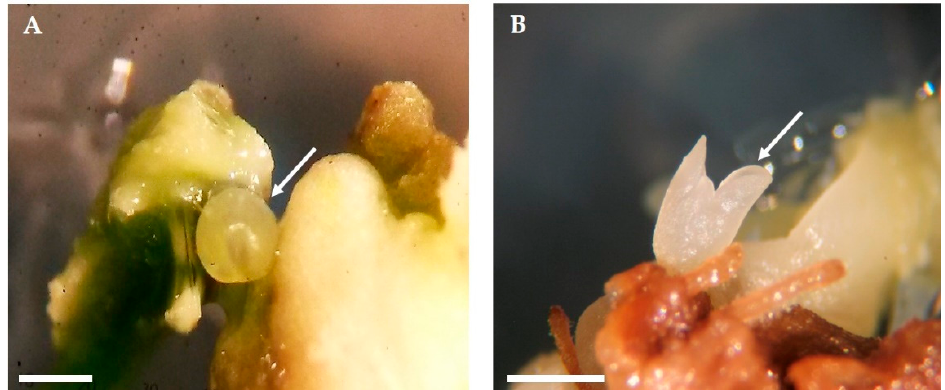
Figure 4. Somatic embryos on the two light regimes 30 days after inoculation in OMc medium devoid of growth regulators. Somatic embryo at the globular stage arising in calli established under 16 h photoperiod ( A ) and embryo at the cotyledonary stage arising in calli established under dark condition ( B ). Bars: 10 mm.